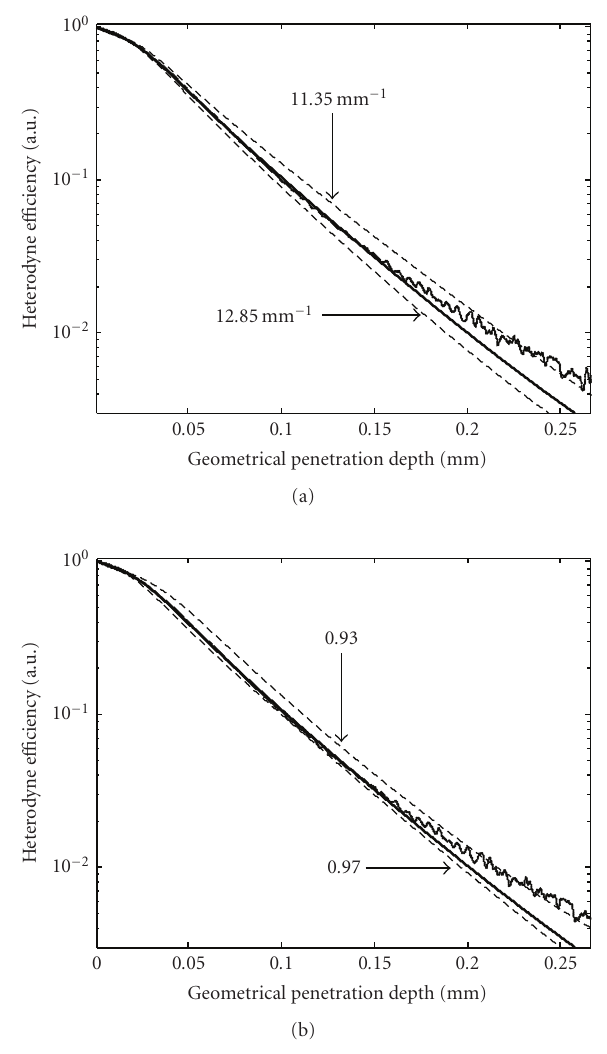
Figure 3: Best numerical fit with the experimental heterodyne profile is obtained for values of μ = 12 . 15 mm − 1 and g = 0 . 95 for the attenuation coe ffi cient and anisotropy parameter, respectively. The numerical fit is the middle line that follows closely the experimental heterodyne e ffi ciency curve shown in both (a) and (b) parts of the figure. (a) Variations of the numerical fit induced by changes of ± 0.7 mm − 1 in the attenuation coe ffi cient with the anisotropy scattering factor kept at g = 0 . 95. (b) Variations in the numerical fit induced by variations of ± 0.02 in the scattering anisotropy parameter with the attenuation coe ffi cient kept at μ = 12 . 15 mm − 1